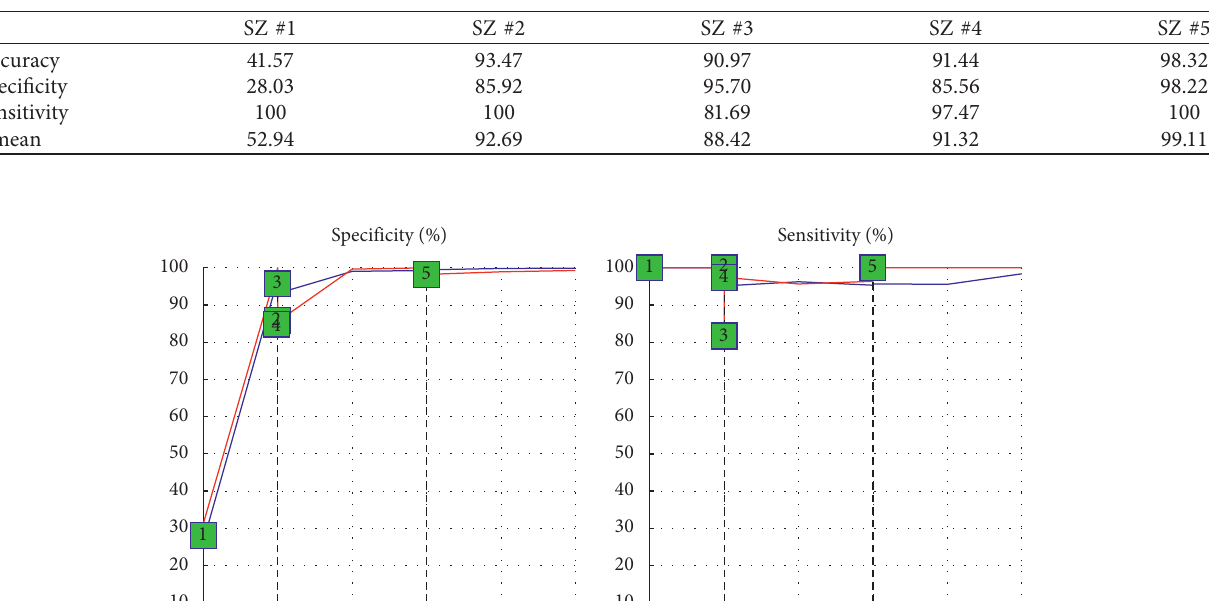
Table 6: Test Performance (%) of the cross-patient seizure detection system of patient #5.